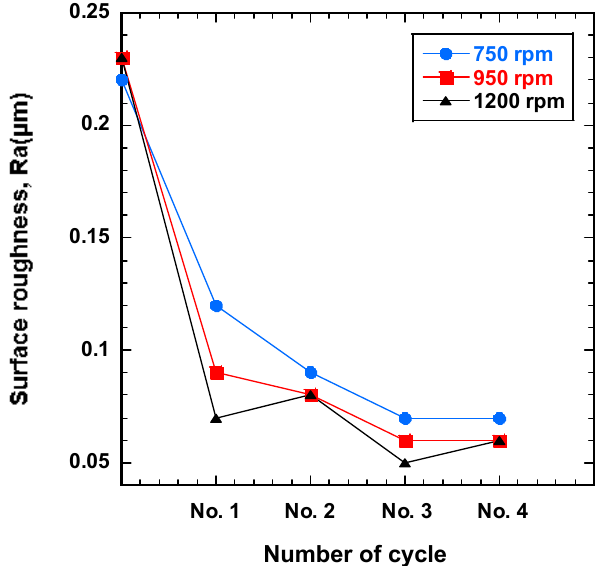
Figure 6. Surface roughness (Ra) as a function of the number of finishing cycle for different magnetic field rotation speeds with industrial magnetic abrasive tools.